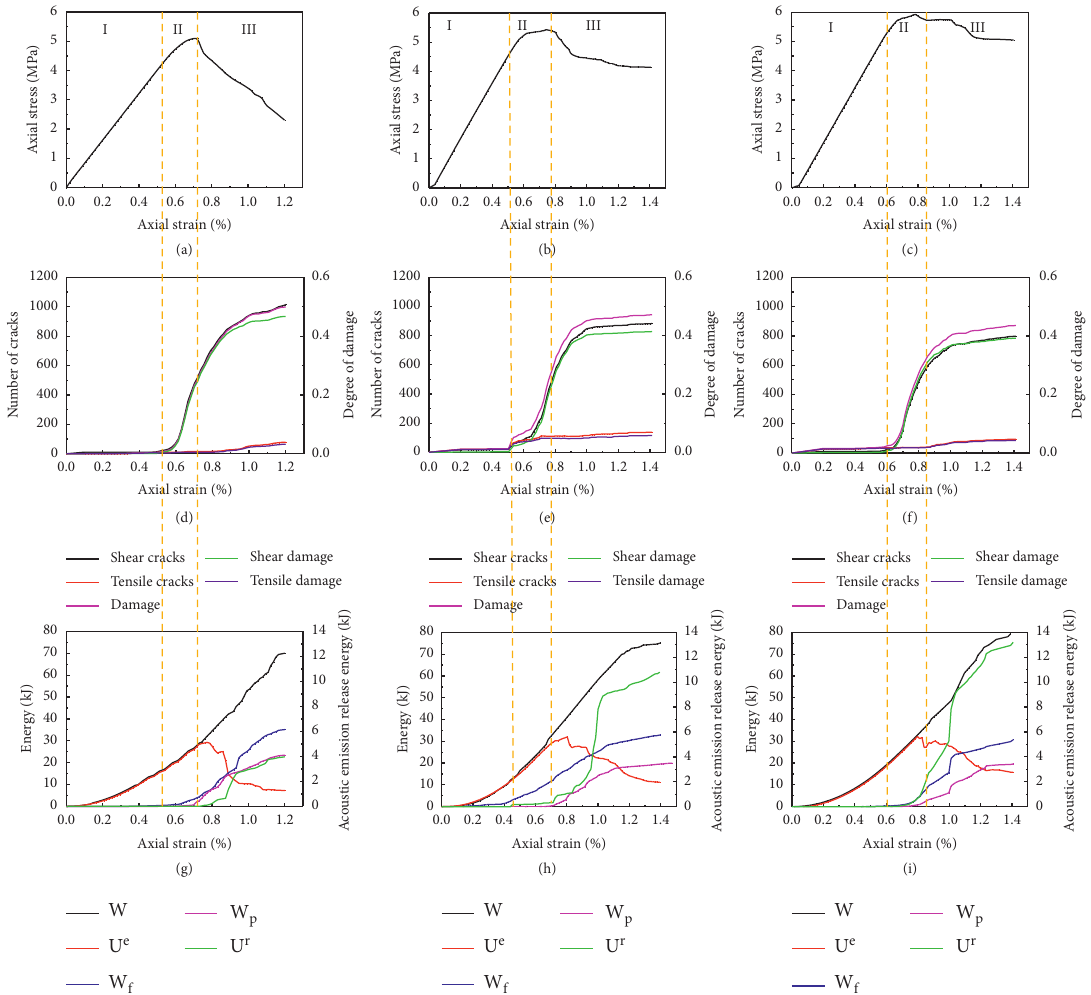
Figure 4: Strength, fracture, and energy evolution of the anchorage body under uniaxial compression: (a) stress-strain curve (no rock bolt); (b) stress-strain curve (low pretensioned rock bolt); (c) stress-strain curve (high pretensioned rock bolt); (d) crack and damage curve (no rock bolt); (e) crack and damage curve (low pretensioned rock bolt); (f) crack and damage curve (high pretensioned rock bolt); (g) energy curve (no rock bolt); (h) energy curve (low pretensioned rock bolt); and (i) energy curve (high pretensioned rock bolt).